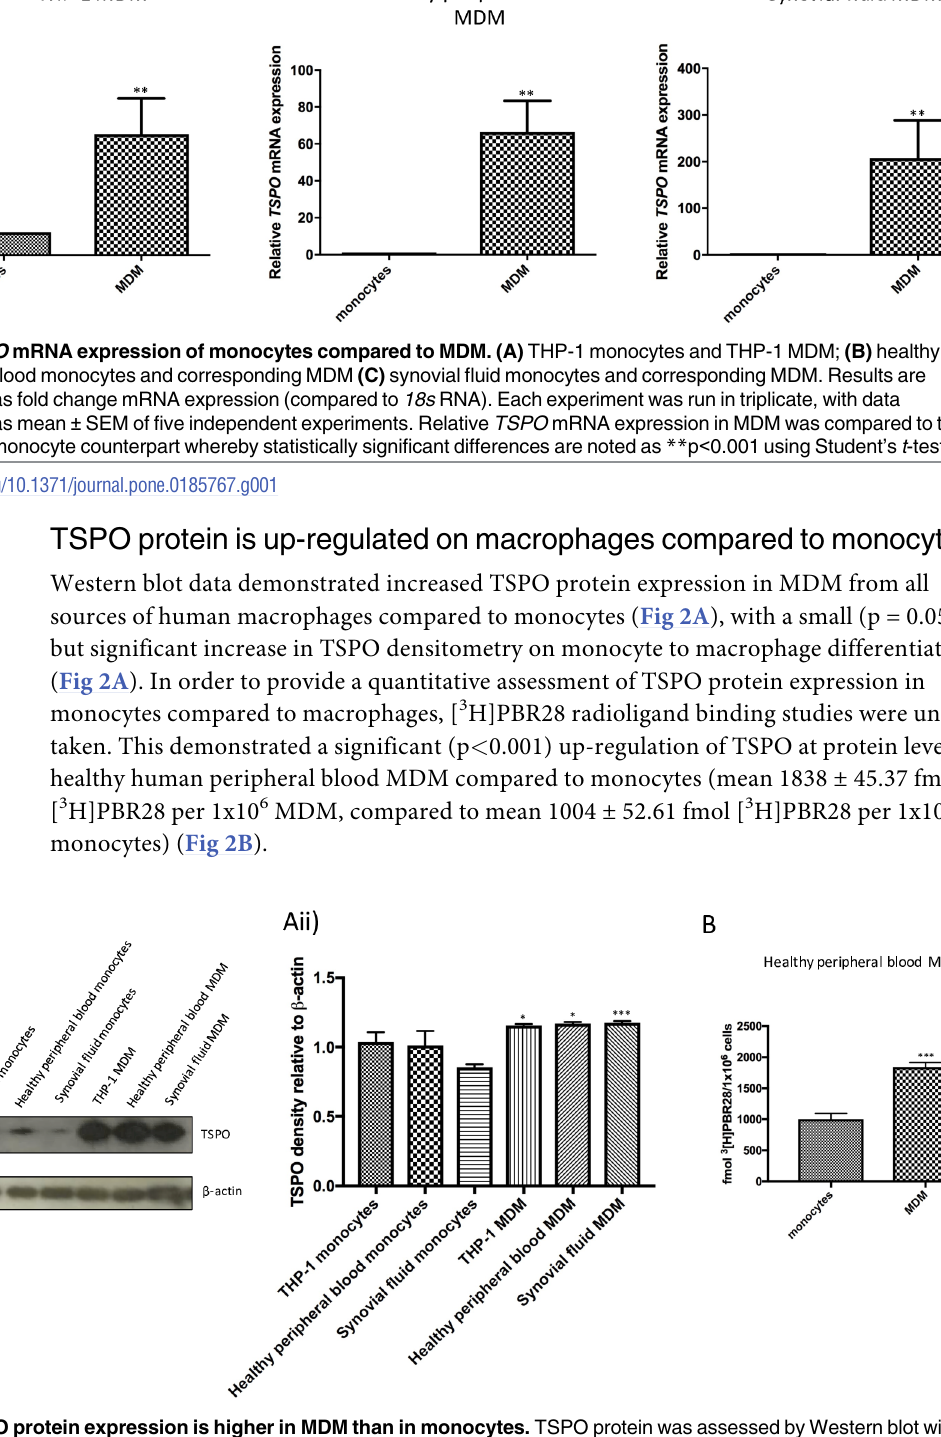
Fig 2. TSPO protein expressionis higher in MDM than in monocytes. TSPO protein was assessed by Western blot with β - actin as loadingcontrol (Ai) , with accompanying densitometry normalisedto β -actin (Aii) . Results shown are for THP-1 monocytes, healthyperipheralblood monocytes, synovial fluid monocytes, and correspondingMDM. (B) [ 3 H]PBR28 tracer bindingper 1x10 6 cells in healthyhuman peripheral blood monocytes and MDM. Each experiment was run in triplicate, and data expressedas mean ± SEM for five independent experiments. *** p < 0.001using Student’s t -test, comparing data from each MDM with that of their counterpartmonocytes.